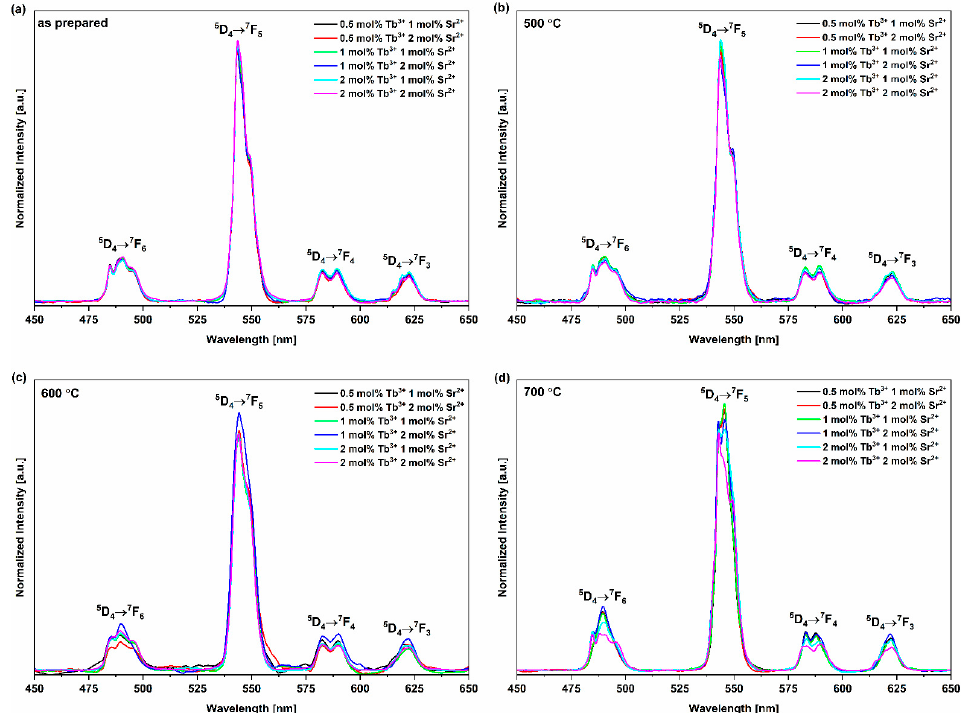
Figure 6. Emission spectra of series ( a ) thermally untreated (as prepared), ( b ) annealed at 500 ◦ C, ( c ) annealed at 600 ◦ C and ( d ) annealed at 700 ◦ C at an excitation wavelength of 266 nm. There are four peaks characteristic of Tb 3+ ions originating from 4f-4f intraconfigurational 5 D 4 → 7 F J (J=3,4,5,6) transitions. The number of Stark components varies in the spectra depending on the annealing temperature.